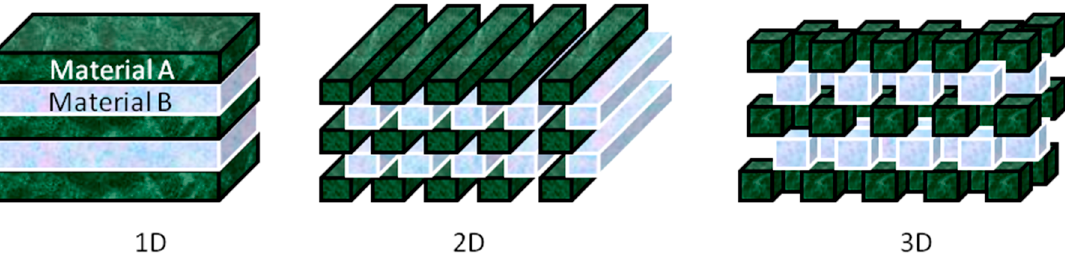
Figure 1. Schematic representation of 1D, 2D, and 3D PCs. The classification of dimensionality is determined by the spatial arrangement of the two materials having different refractive index.